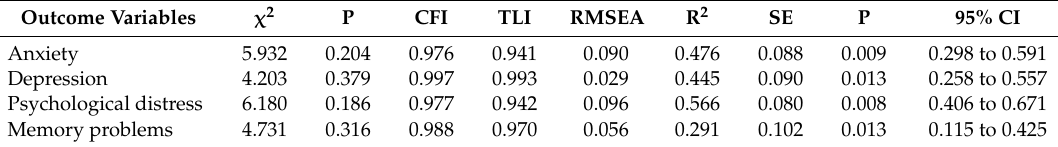
Table 3. Summary of model-data fit and the percentages of variance explained by trimmed path